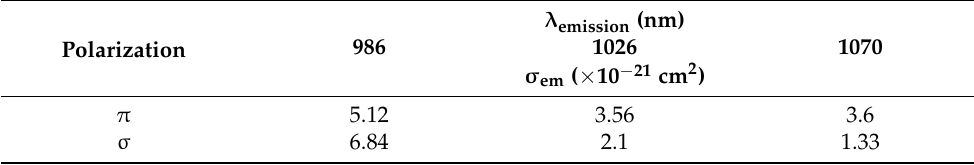
Figure 23. Polarized emission cross ‐ section spectra of LYSB:Yb (4 at.%) crystal at room temperature. Reprinted with permission from ref. [44], copyright 2020, Elsevier. Table 10. Emission cross ‐ sections of LYSB:Yb (4 at.%) crystal.